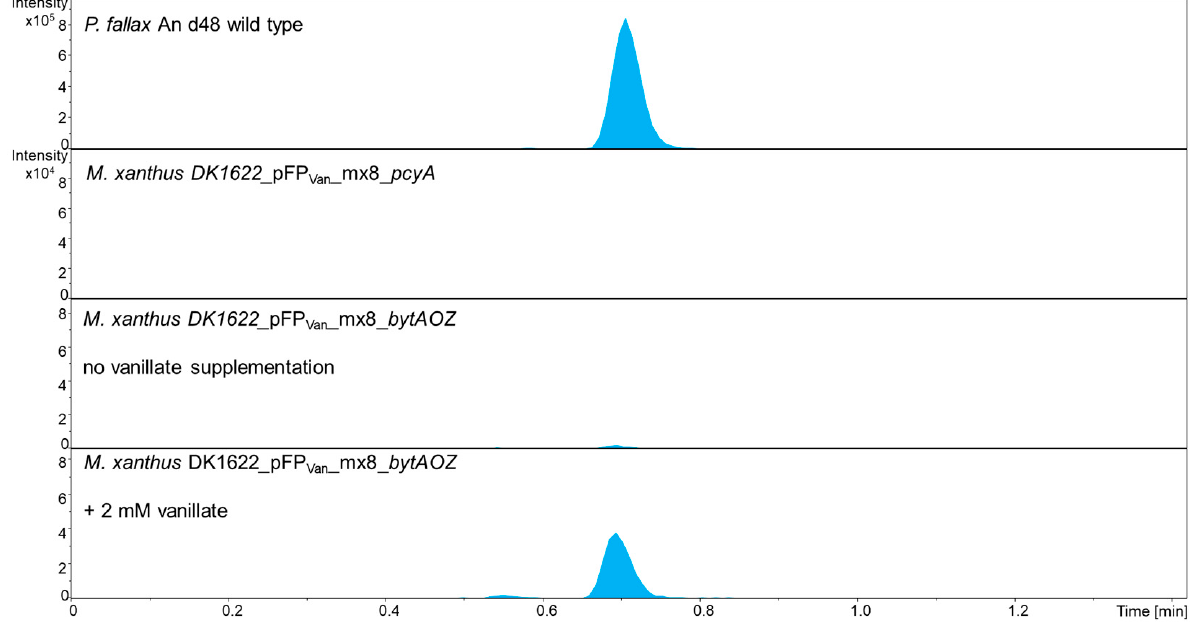
Figure 5. Heterologous production of the myxobacterial biarylitide MeYLH ( 1 ) in M. xanthus DK1622. HPLC − MS EIC of crude extracts from P. fallax An d48 wild type as the positive control and M. xanthus DK1622_pFPVan_mx8 mutant strain as the negative control. While the HPLC − MS EIC of the crude extract from M. xanthus DK1622_pFP Van _ bytAOZ mutant without vanillate supplementation showed only trace amounts of 1 due to leaky expression, the HPLC − MS EIC of the crude extract from M. xanthus DK1622_pFPVan_ bytAOZ without 2 mM vanillate supplementation indicates low but significant production of 1 . EIC: extracted ion chromatogram; blue, 222.615 ± 0.05 Da [M + 2H] 2+ .